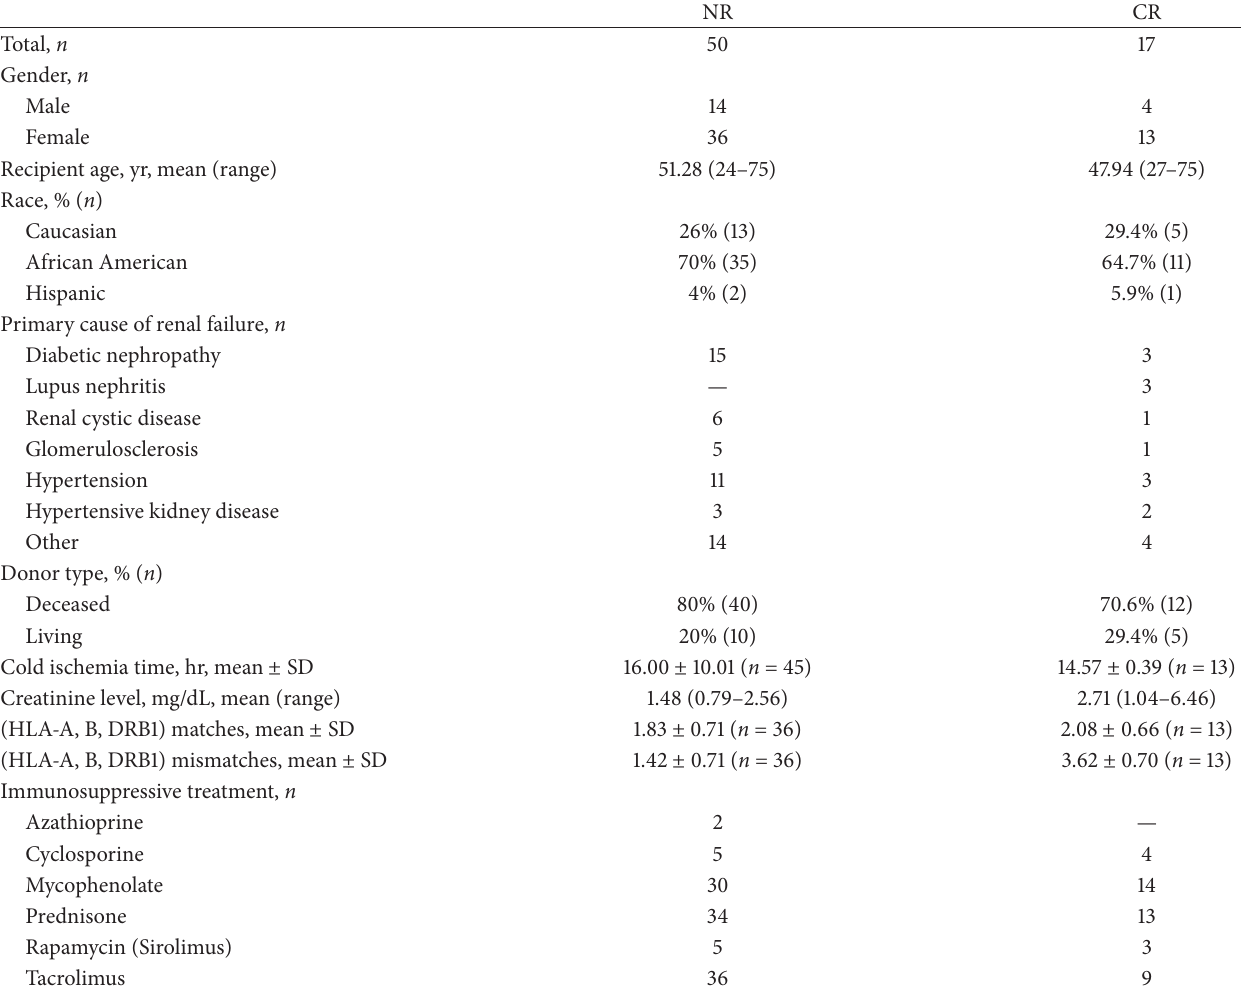
Table 1: Demographic, clinical, therapeutic, and transplant-related parameters of the